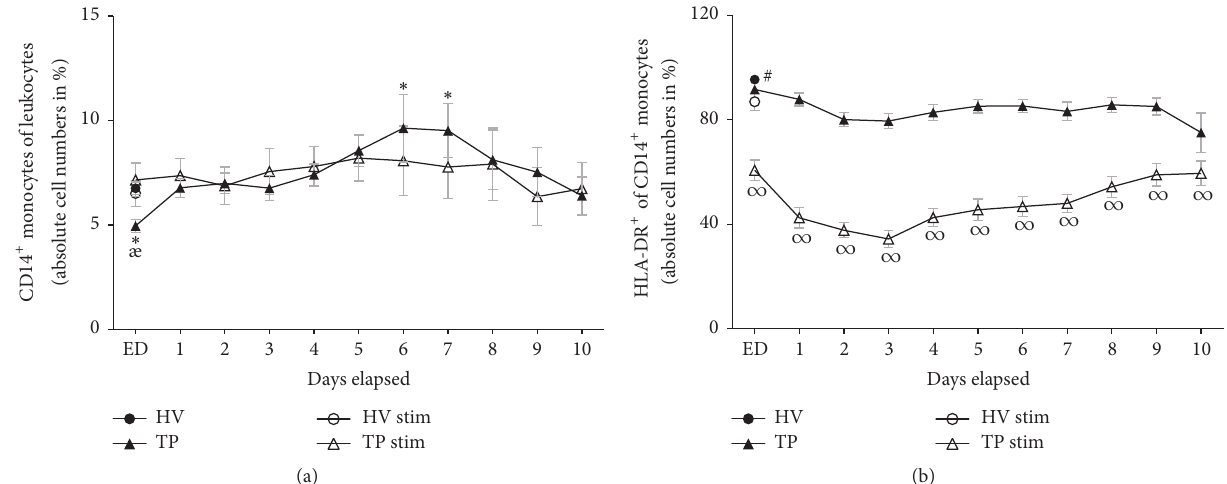
Figure 3: Whole blood from healthy volunteers (HV, 𝑛 = 14 ) or major trauma patients (TP, 𝑛 = 29 ) was analyzed by flow cytometry over a 10-day time course after admission (emergency department, ED–10). Monocytes were detected using anti-human CD14 in the corresponding sidewardandforwardscatter.Unstimulated(blacksymbols)andstimulated(clearsymbols)measurementsweremade.Forstimulation(stim), whole blood was incubated with leukocyte activation cocktail for 5h with subsequent analyzing procedure as in unstimulated samples. Data are shown as mean ± SEM. (a) CD14 + monocytes to leukocytes ratio, (b) HLA-DR expression in CD14 + monocytes. ∗ 𝑝 < 0.05 versus unstimulated HV; æ 𝑝 < 0.05 TP versus corresponding TP stim; # 𝑝 < 0.05 HV ctrl versus all; ∞ 𝑝 < 0.05 TP stim versus corresponding unstimulated TP and HV